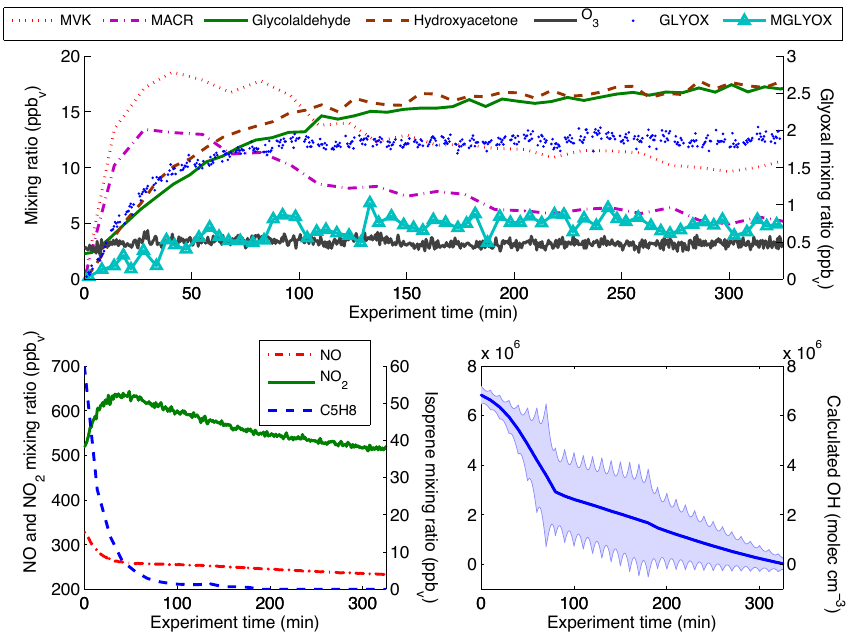
Fig. 1. Timeseries of measured compounds for Exp.7. OH is the average of that calculated from ISP, MVK, and MACR. See Supplement for details about OH